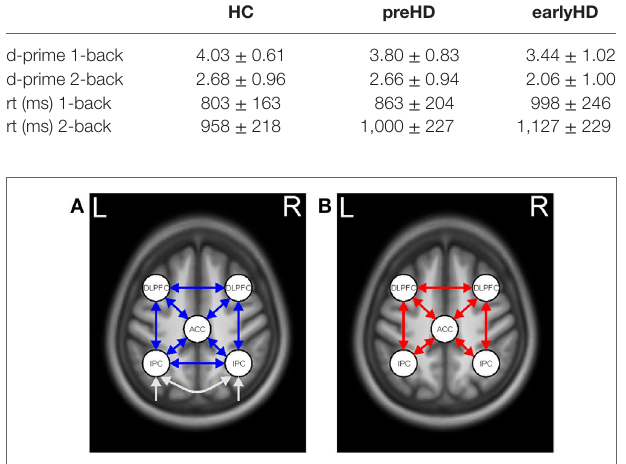
FigUre 2 | Dynamic causal model for working memory (WM). (a) Task-independent, intrinsic connections (blue arrows) and driving input (white arrows). (b) WM-modulated connections (red arrows).